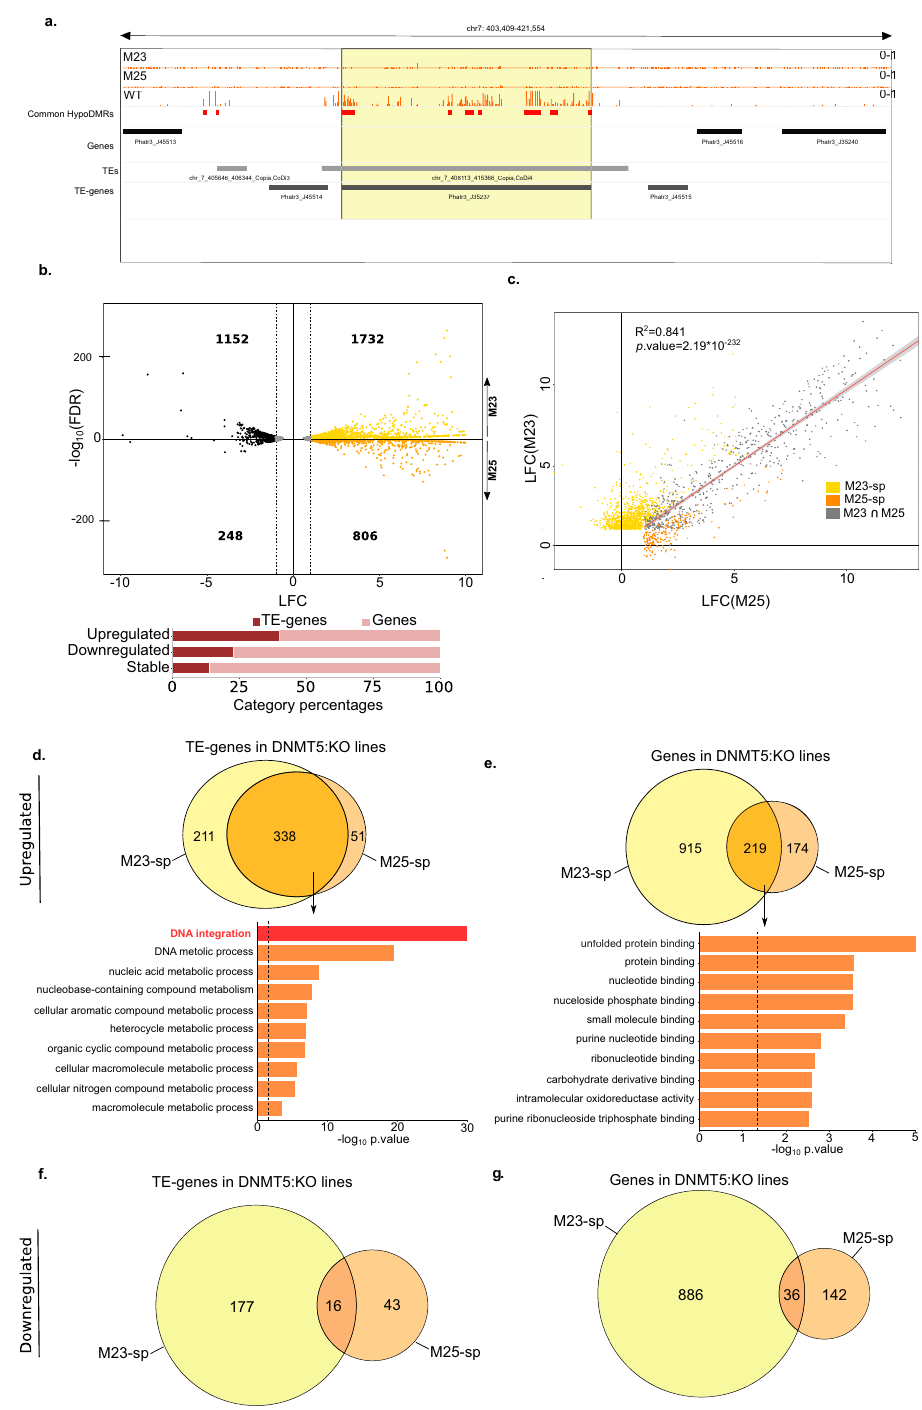
nucleotide phosphate metabolism and nucleotide binding activity (Fig. 4e, Supplementary Data 12). This is typi fi ed by the overexpression of chaperone DnaJ domain-containing proteins and Hsp90-like proteins (Supplementary Data 13). The down- regulation of genes was not consistent between M23 and M25 as only 35 genes and 16 TE-genes are downregulated in both cell lines (Fig. 4f, g, Supplementary Data 14). Expression levels of 12 genes was con fi rmed by qPCR in the M23 cell line, including DnaJ and HSP90-like protein coding genes mentioned previously (Supplementary Fig. 7a, b, Supplementary Data 15). Of note DNMT5a (Phatr3_EG02369) is among the downregulated genes